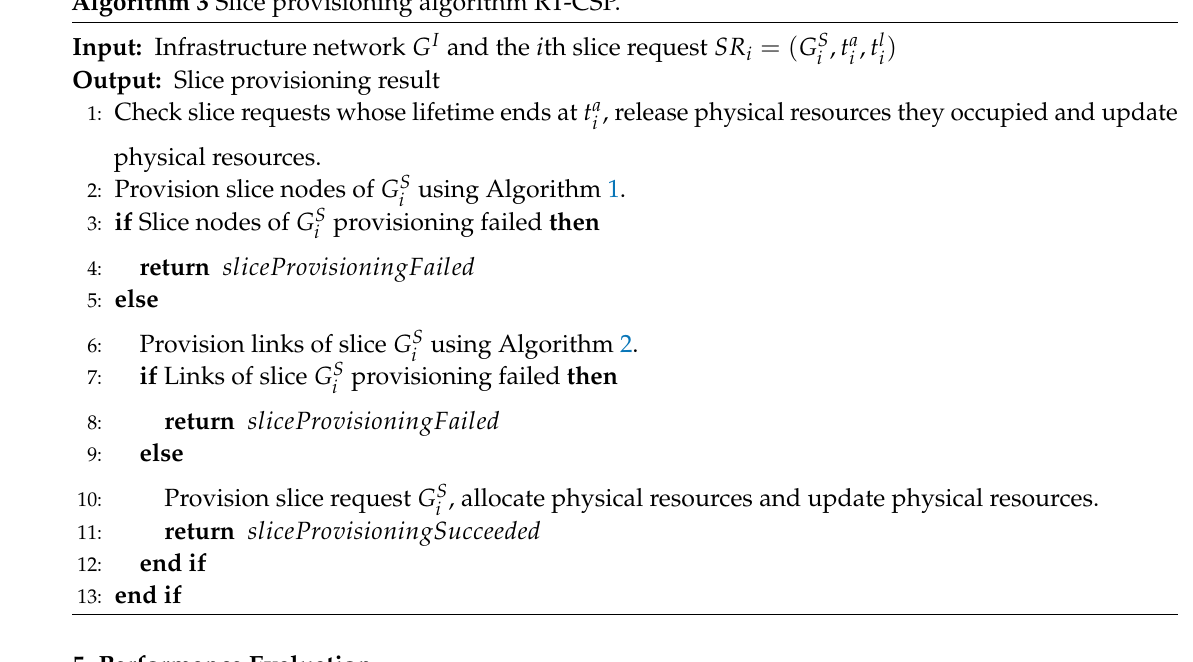
Algorithm 3 Slice provisioning algorithm